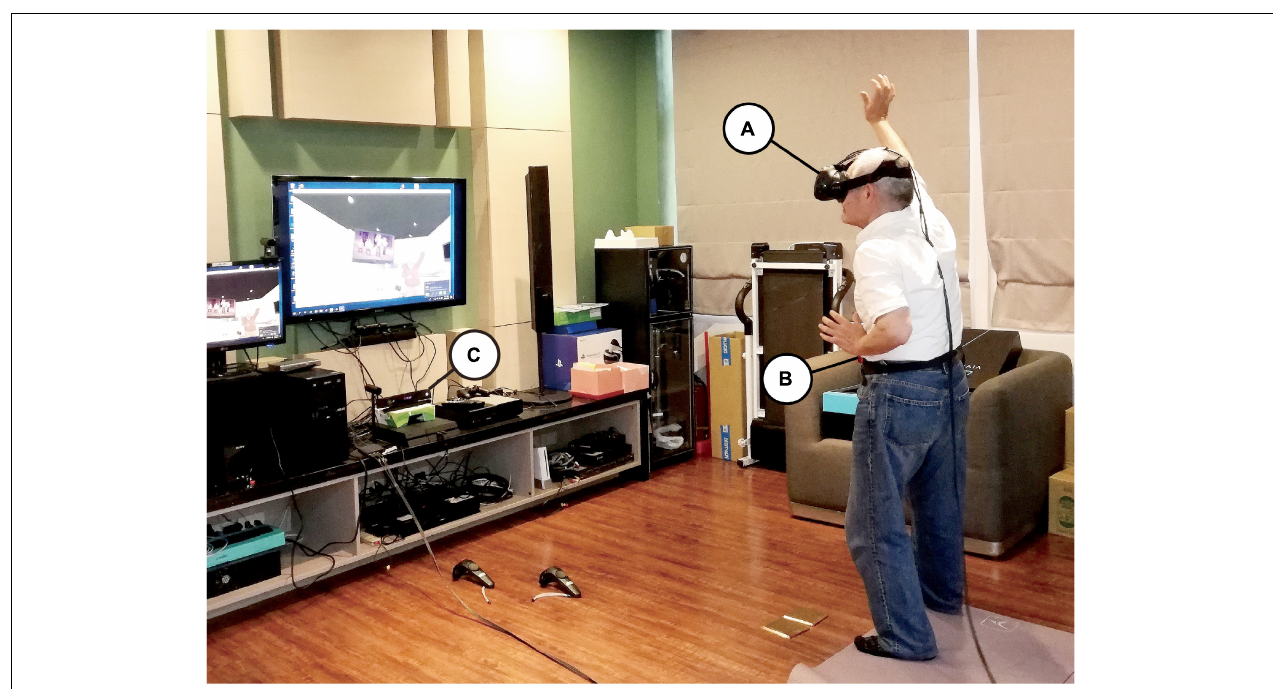
FIGURE 1 | Experimental setup. (A) hTC VIVE head-mounted display. (B) ActiGraph wGT3X-BT accelerometer. (C) Microsoft Xbox One Kinect